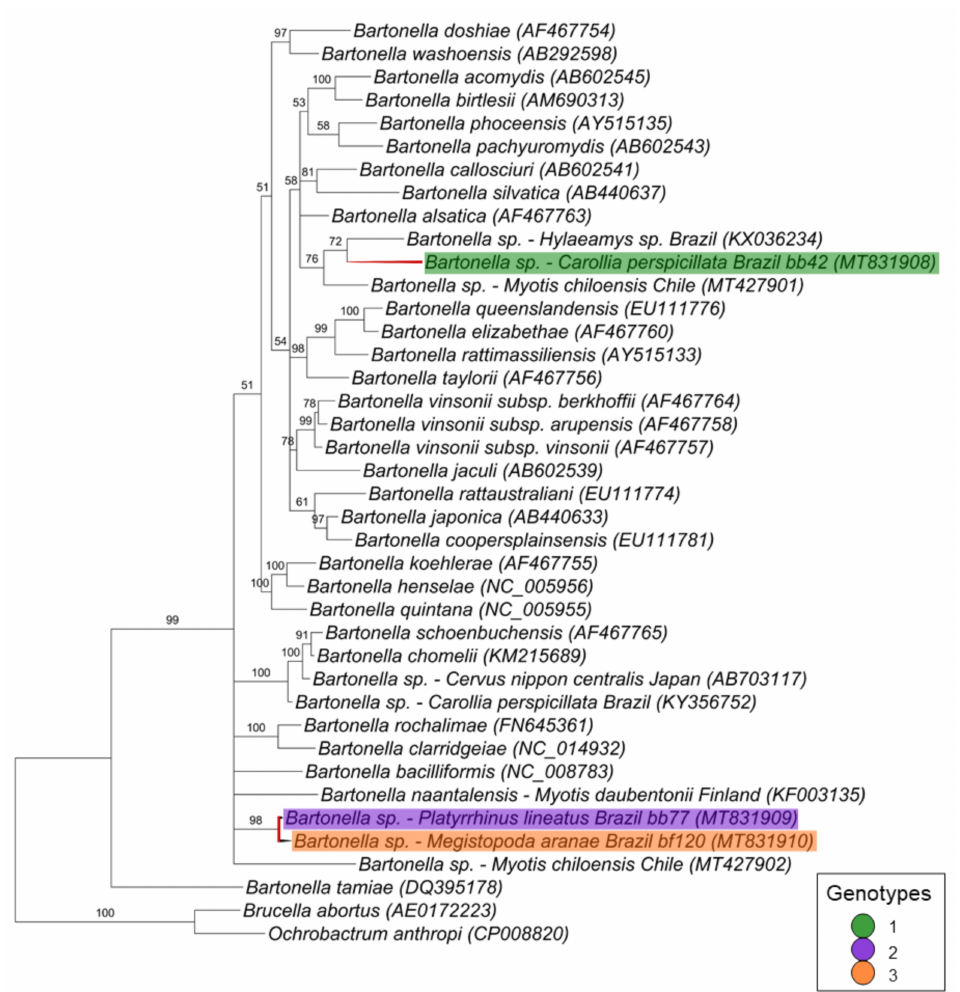
Figure 6. Phylogenetic tree based on an alignment of 521 bp fragment of Bartonella spp. ftsZ sequences, using the Bayesian Inference method and the TIM1 + I + G as evolutionary model. Numbers at nodes correspond to the posterior probability value support. Each sequence is highlighted according to its respective genotype. Each sample is designated with the type of sample (bb = bat blood and bf = bat fly) followed by the referred animal